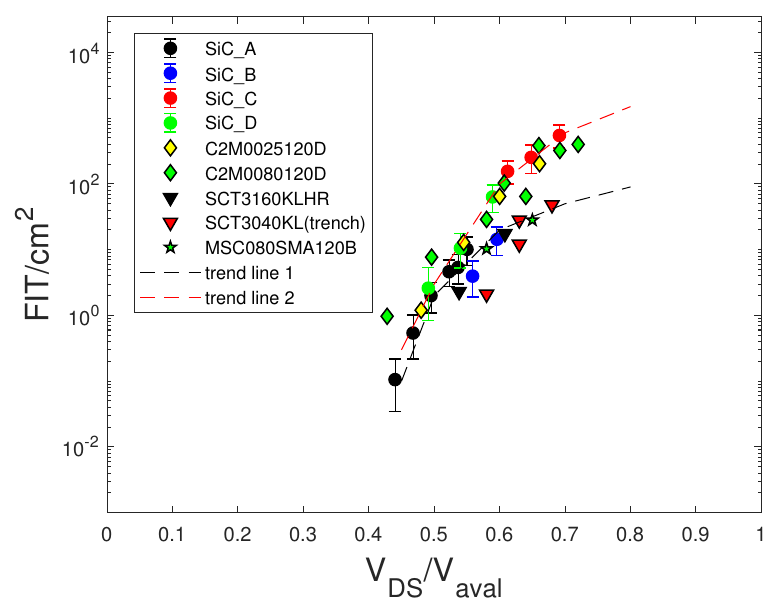
Figure 8. Measured ( • ) FIT data at sea level of SiC MOSFETs normalized to the active area versus V DS / V aval . Data of the commercial SiC MOSFETs C2M0025120D (Cree), SCT3160KLHR -1200 V (ROHM), SCT3040KL-Trench (ROHM), and MSC080SMA120B (Microsemi) from [11].